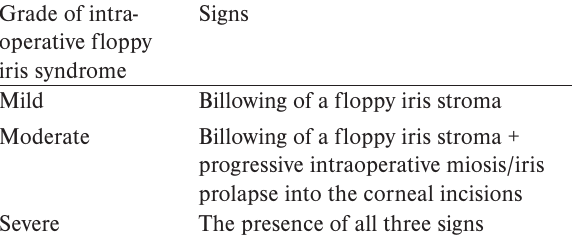
Table 1. The +grade of intraoperative floppy iris syndrome is determined by the presence of following